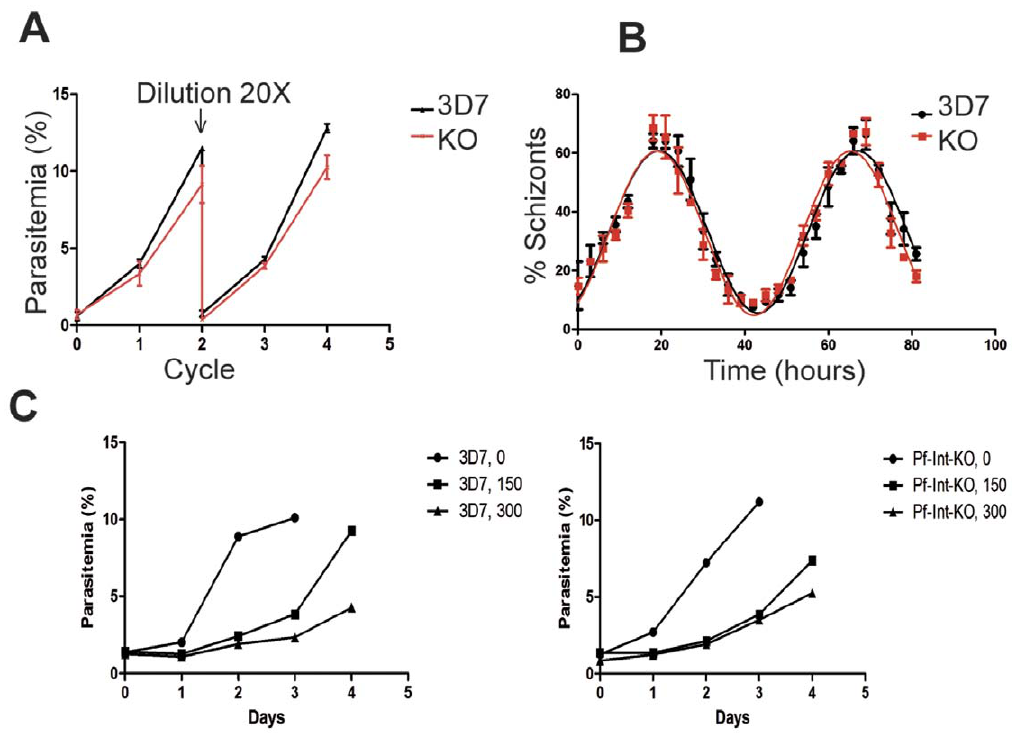
Figure 2. Pf-Int is non-essential for the intra-erythrocytic parasite growth. A ) The effect of the gene disruption was examined by comparison of synchronized cultures of WT (black line) and KO (red line) parasites for four cycles. The cultures were diluted 20 times at the end of the second cycle. Values are the mean of two independent experiments whose standard deviation is shown by the bars. B ) Synchronous cultures of the WT (black circles) and KO (red squares) parasites were grown for 80 hours and sampled every 3 h. The parasite stages were analyzed by flow cytometry and the percentage of parasites at the schizont stage was plotted against time. Values are the mean of two independent experiments whose standard deviation is shown by the bars. The data were fitted to an exponential sine wave equation using Prism program, and the fitting curves are shown. Black line corresponds to the WT cultures, and the red line to the KO cultures. C ) Response to UV-induced DNA damage in 3D7 and Pf-Int-KO parasites. The effect of the gene disruption was examined by comparison of WT 3D7 (Left panel) and Pf-Int-KO (Right panel) parasites after UV irradiation at different doses (0, 150 and 300 6 100 m J/cm 2 ). Synchronous cultures were grown for 4 days after irradiation and sampled every day. The parasitemia was determined by flow cytometry. One representative experiment of two is shown.